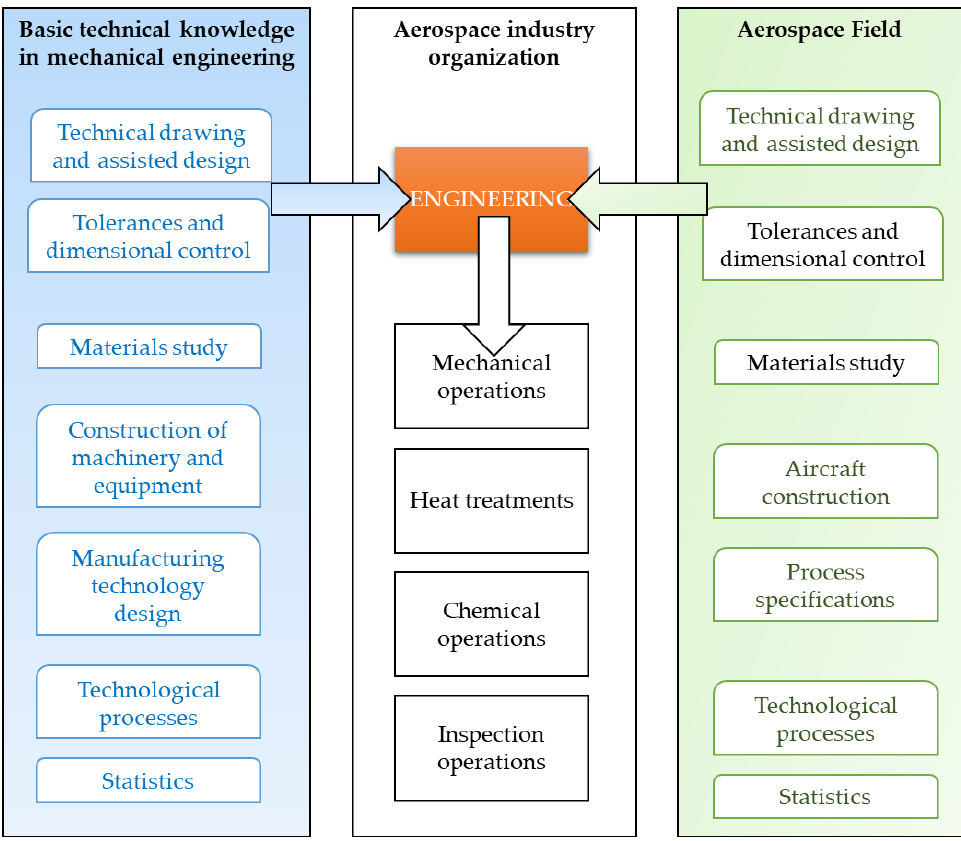
Figure 6. Types of knowledge used in aerospace industry organizations with a focus on the manu- facture of mechanical structural components. ture of mechanical structural